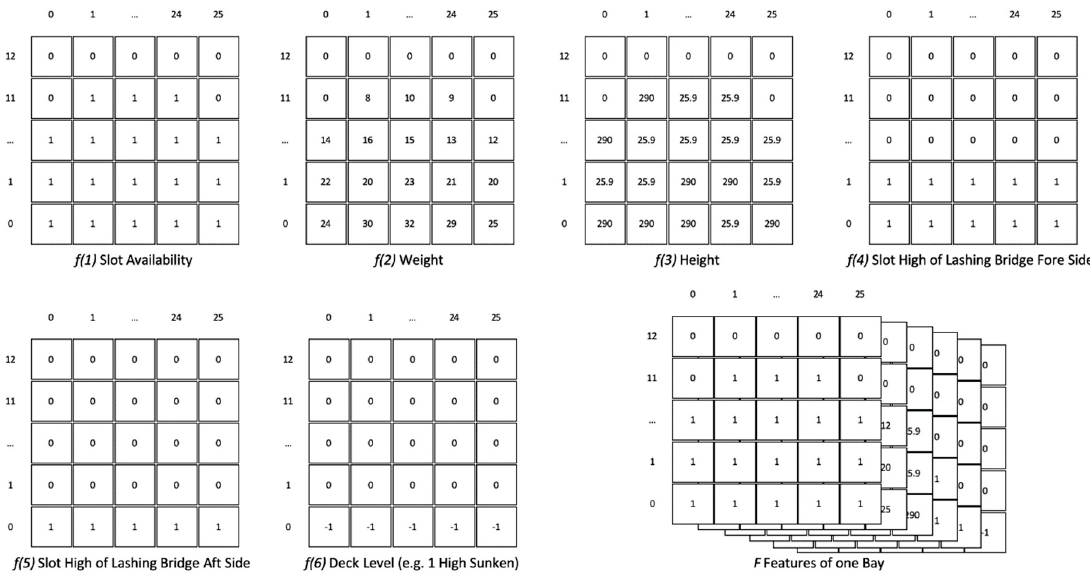
Figure 6. Example of extracted features.